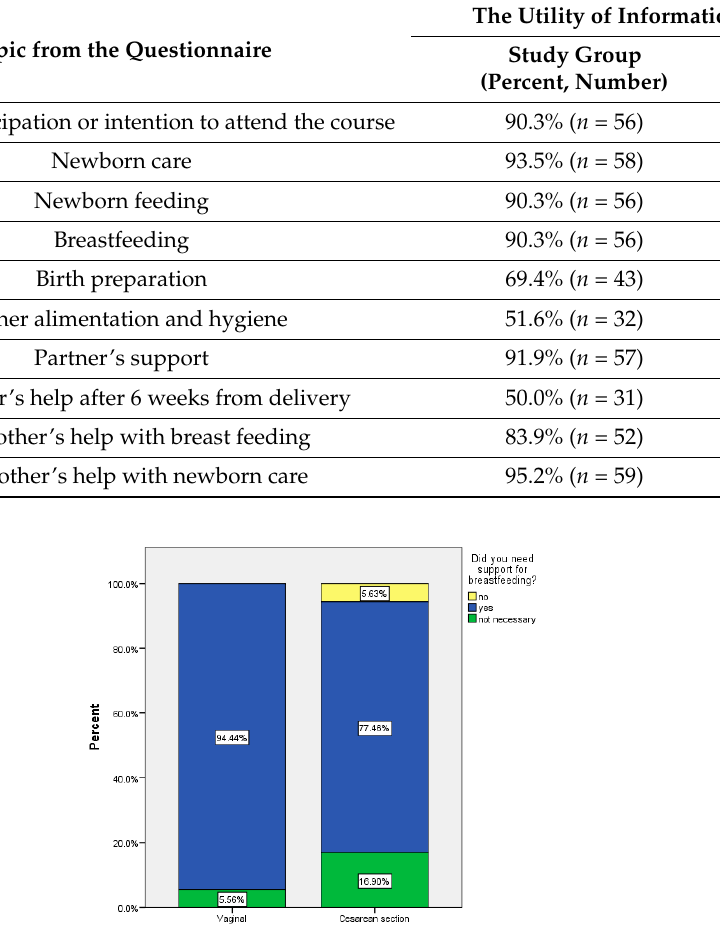
Table 1. The utility of topics from the questionnaire.